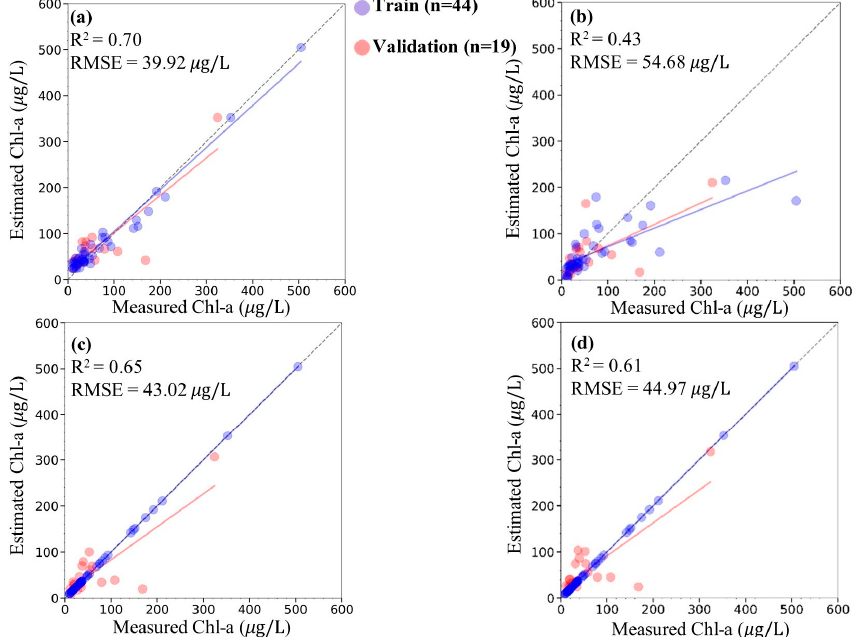
Figure 10. Statistical metrics of collaborate retrieval without the degradation process using four machine learning models. ( a ) Adaboost model; ( b ) SVR model; ( c ) XGboost model; ( d ) GBDT model.